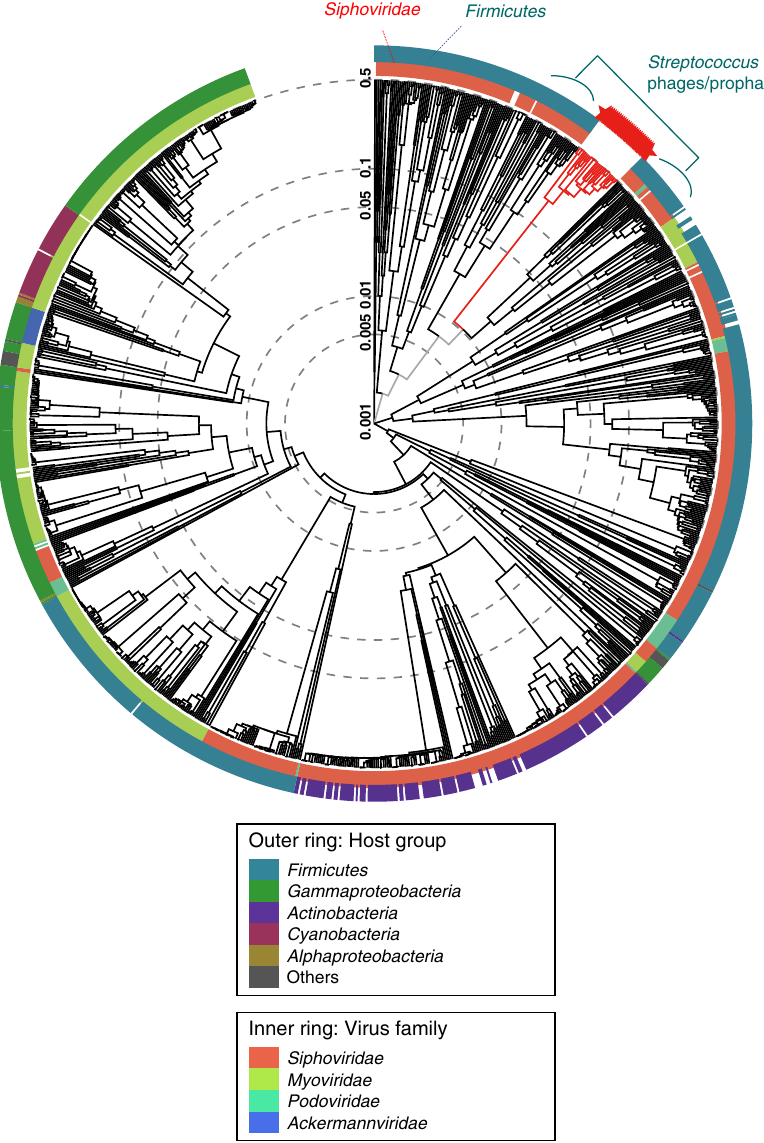
Fig. 3 Proteomic tree showing a group of high coverage oral phages/prophages. The red lines at the top right indicates the group consisting of the 28 phages found across the four samples and listed in Supplementary Data